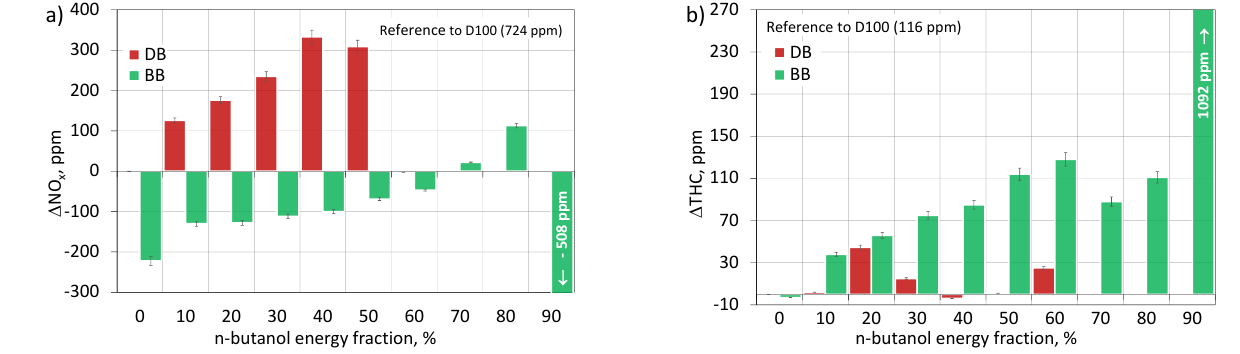
Figure 18. Emission of NO x ( a ) and THC ( b ) for test engine powered by diesel/n-butanol and RME biodiesel/n-butanol blends.